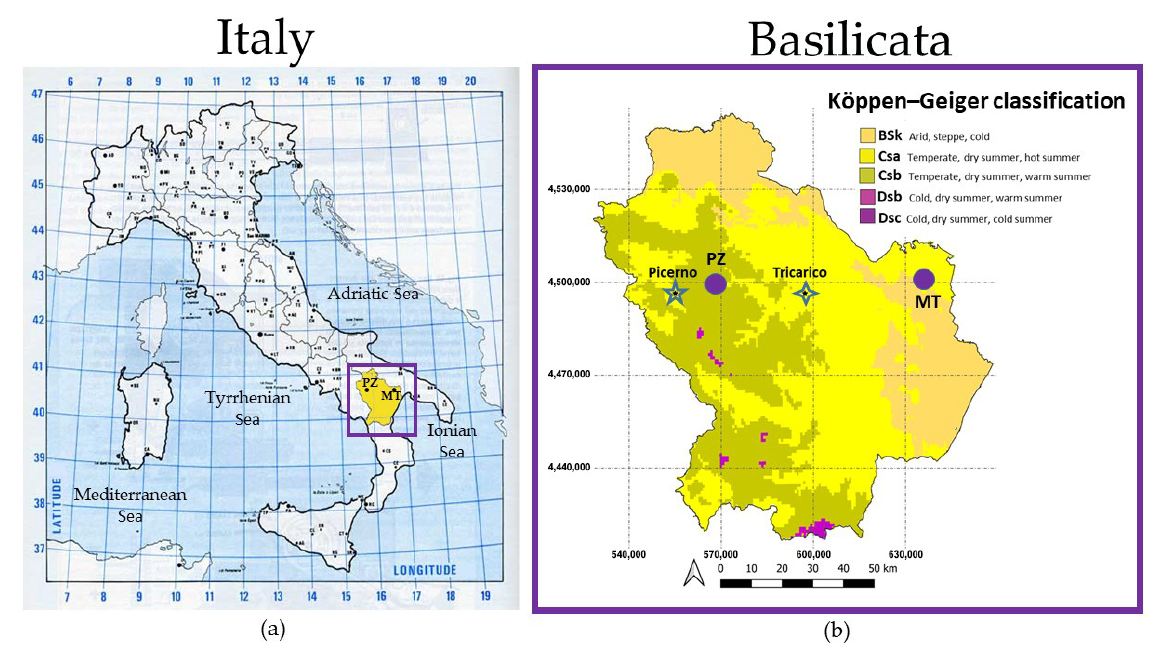
Figure 1. Localization of the Basilicata region on the map showing the 20 regions of Italy ( a ); localization of the two experimental sites in the map of the Basilicata region classified according to Köppen–Geiger climate classification ( b ).